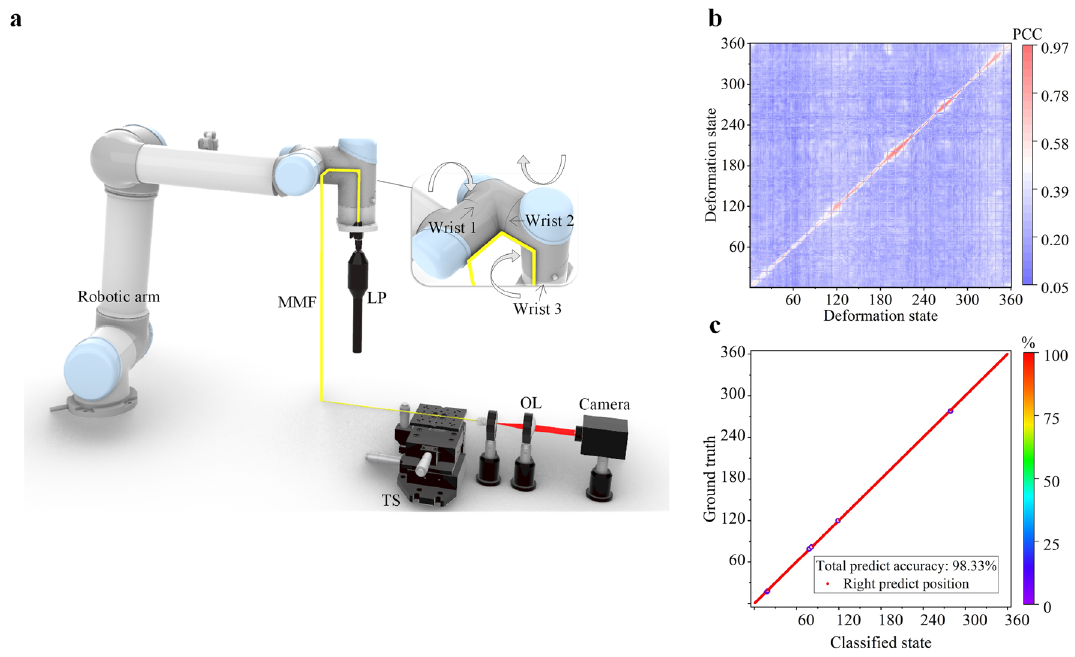
Figure 5. ( a ) Experimental setup for 3D three-point deformation classification; ( b ) Average PCC for 3D three-point bending between the speckles collected in the first measurement and speckles collected in the rest measurements. ( c ) KNN classification result using the last 20% recorded data in 3D three-point bending. The blue-colored circles in c indicate where the classification is